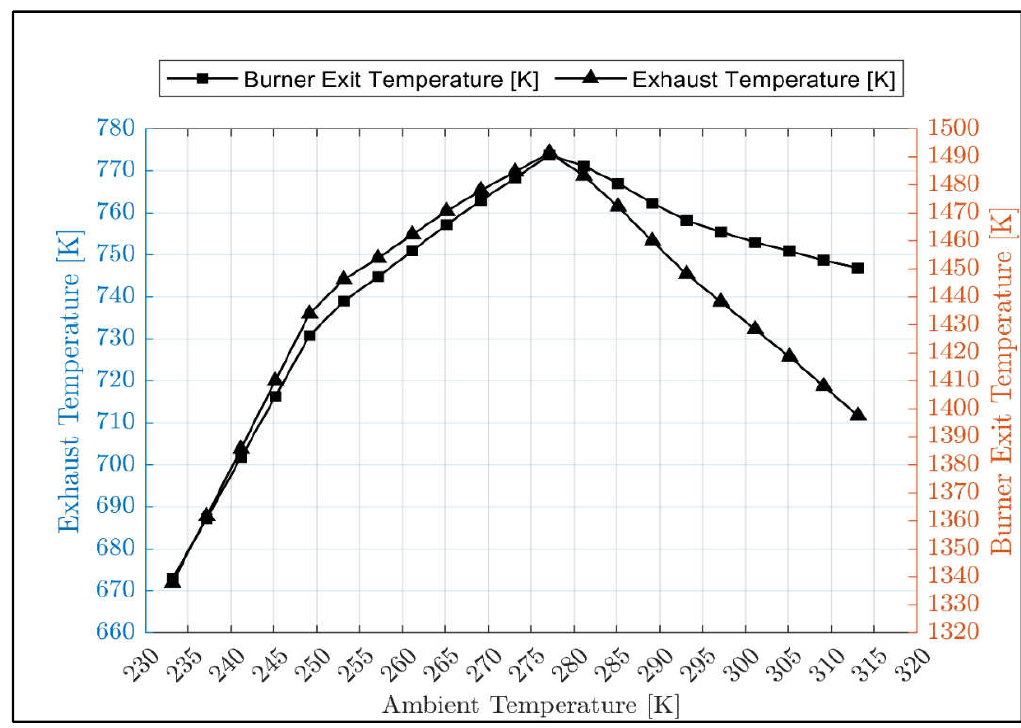
Figure 6. Exhaust temperature and burner exit temperature versus ambient